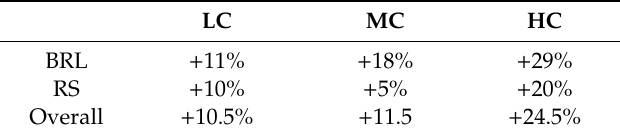
Figure 1. Ready-to-eat leafy green salads’ average total aerobic mesophilic count (TAMC) contamination levels at packaging and expiry date for low-cost (LC), medium-cost (MC) and high-cost (HC) baby romaine lettuce (BRL) and rocket salad (RS) samples (SD < 10%) evaluated using the plate count method. * Significant di ff erence ( p < 0.05). Table 3. Ready-to-eat leafy green salad average total aerobic mesophilic count (TAMC) percent increase in growth from packaging to expiry date for each variety and cost